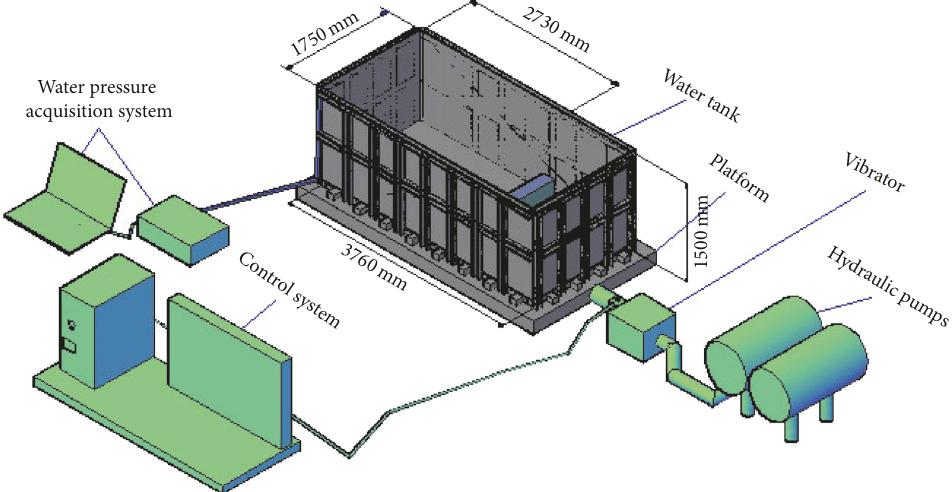
Figure 1: A typical illustration of the experimental setup design.